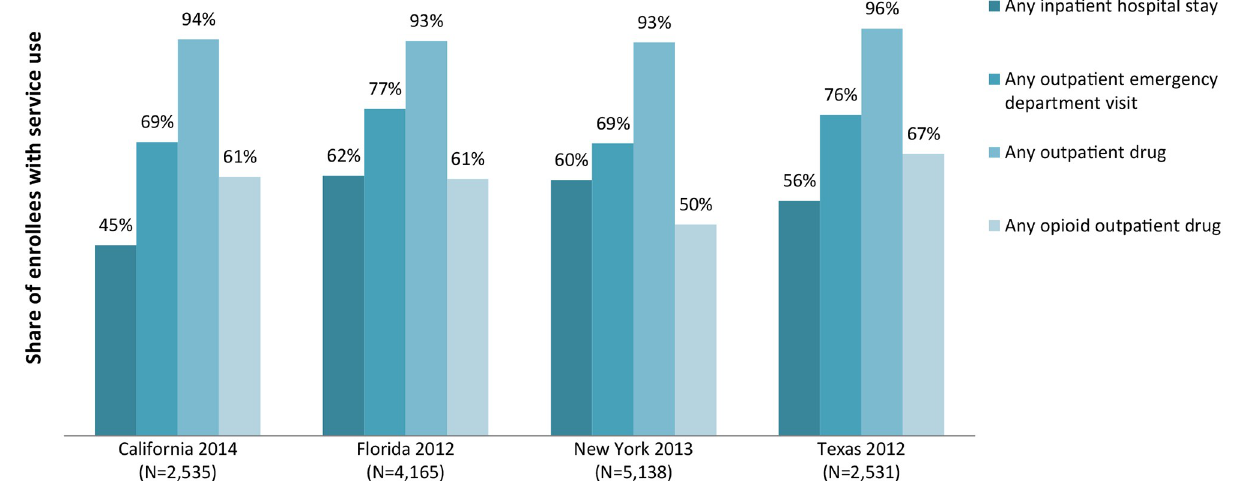
Fig 3. Selected Medicaid utilization metrics for non-dual, full-benefit Medicaid enrollees with SCD. SCD is sickle cell disease.